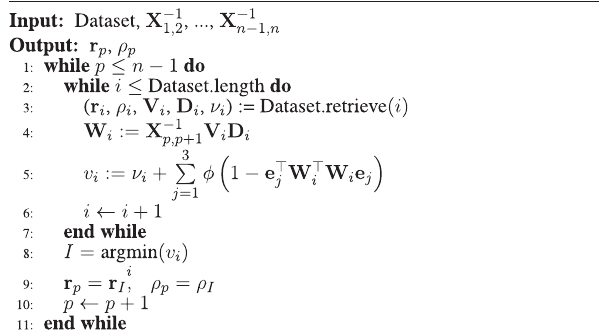
Algorithm 2. Ellipsoids mapping.